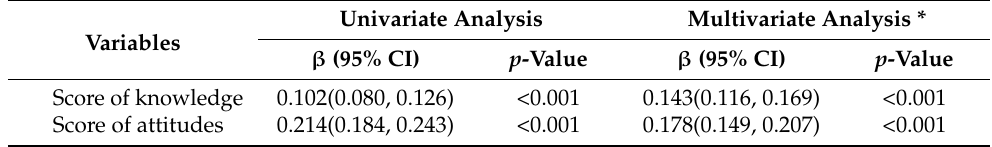
Table 5. Association of salt-related knowledge and attitude scores and the behavior